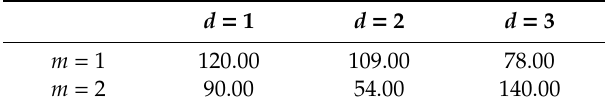
Table 4. Distance between manufacturers and distributors